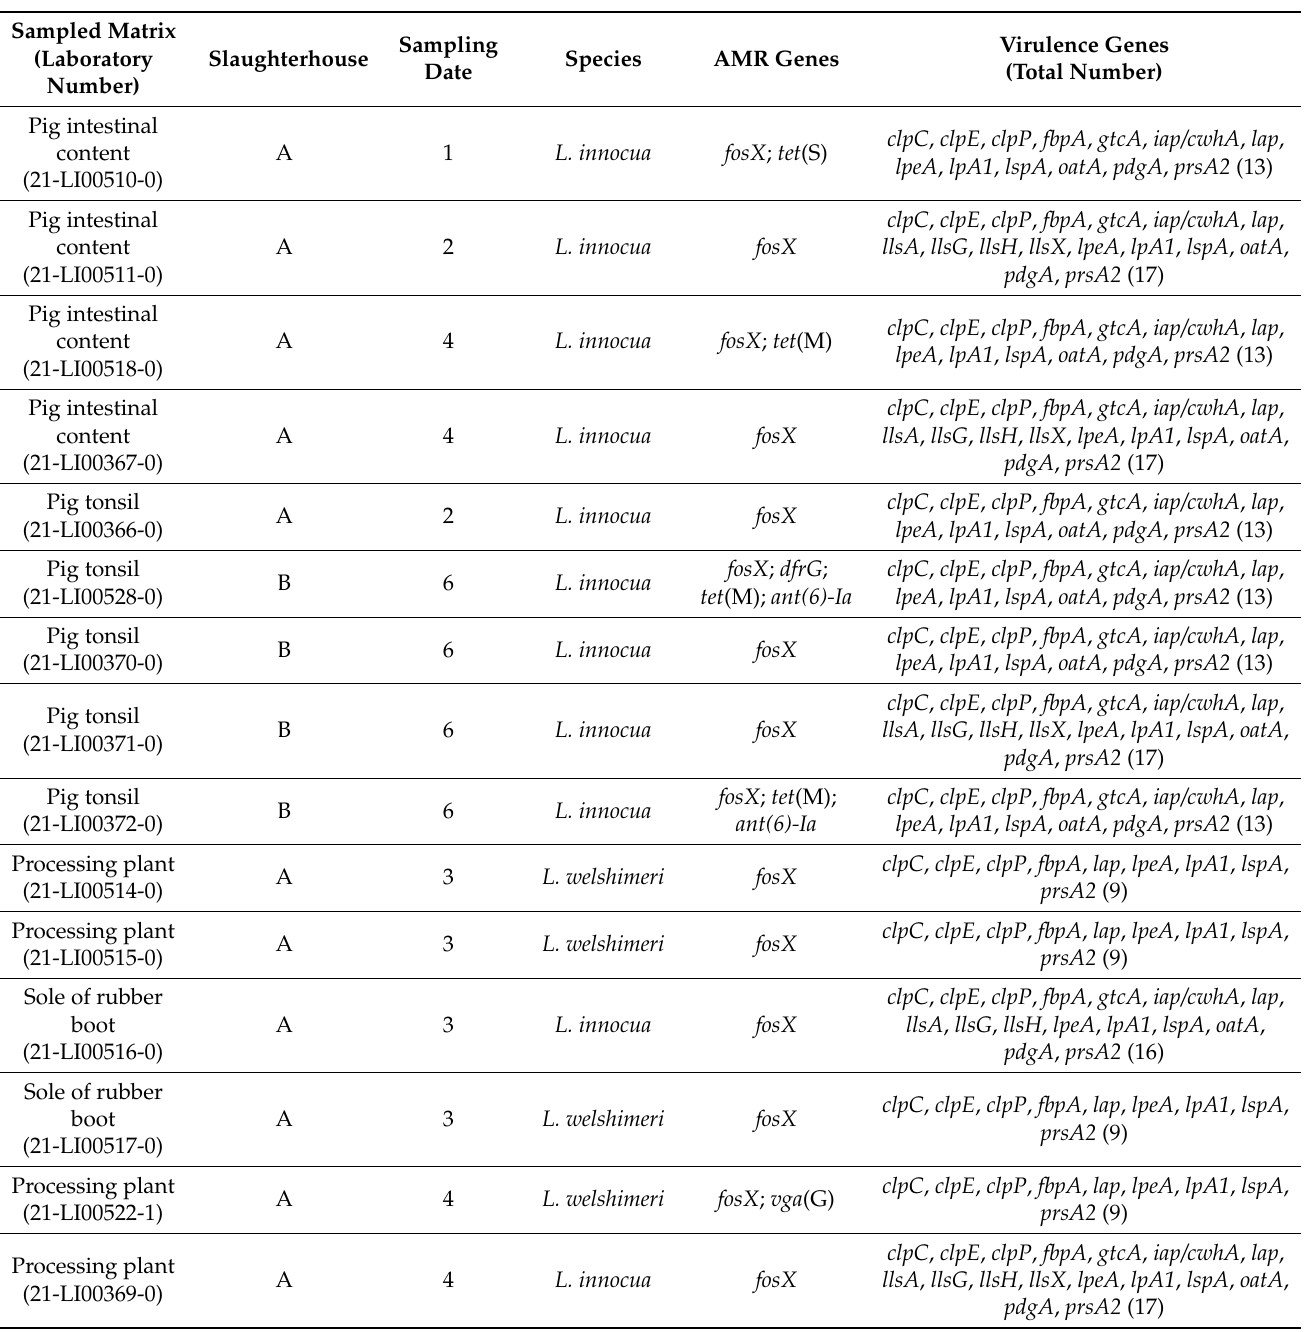
Table 3. Characteristics of Listeria species other than L. monocytogenes found in pigs and the slaughter- house